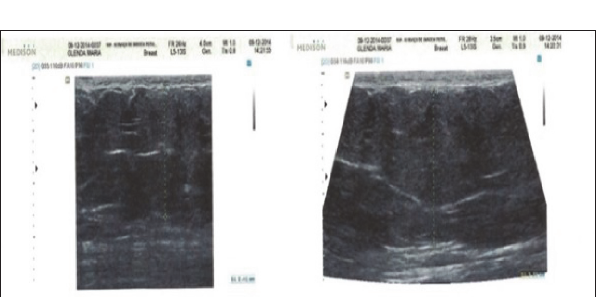
Figure 5: Sonography, 15 days after treatment.